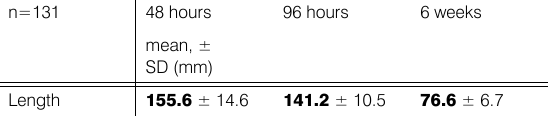
Table 2. Uterine dimensions obtained 48 hours, 96 hours (transab- dominal), and 6 weeks (transvaginal) after Cesarean section.